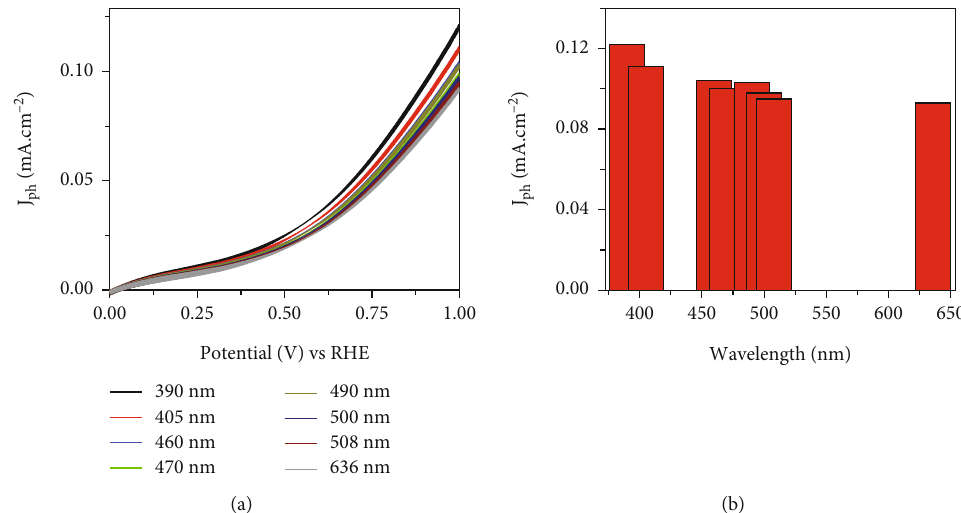
Figure 6: (a) The response of the ATO/PANI/PbS photoelectrode under di ff erent light wavelengths (390 to 636nm) and (b) the J +1V for this photoelectrode at 25 °